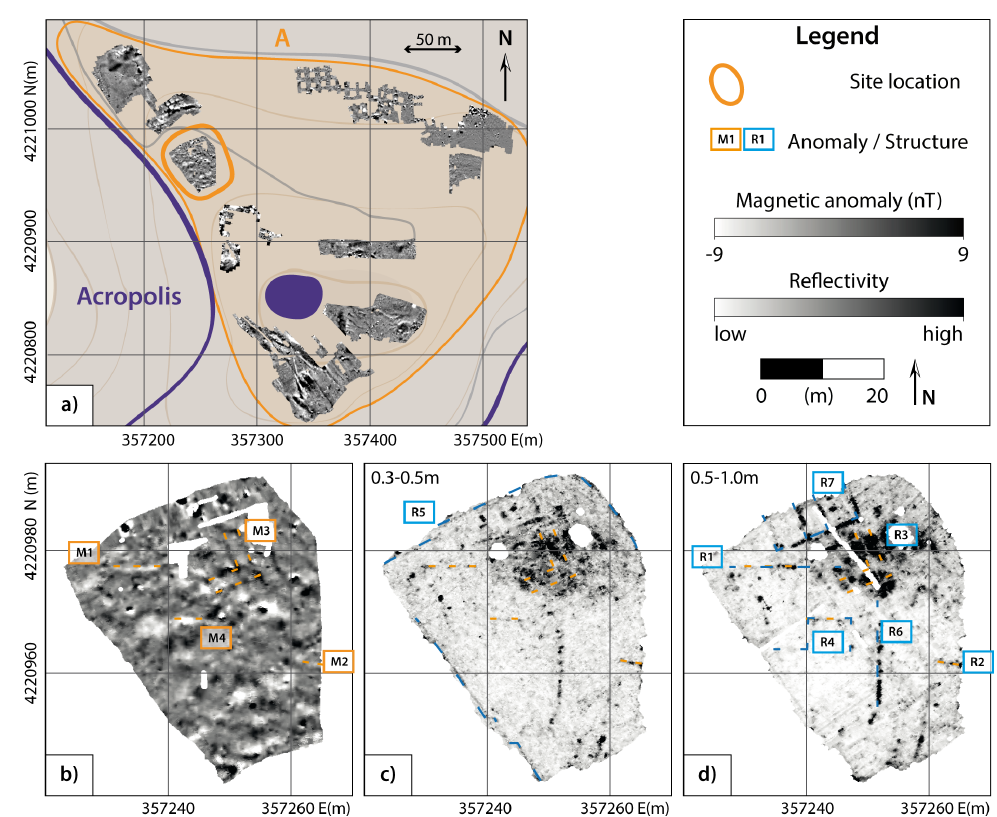
Figure 4. Case 1: Second lower terrace northwest of Aigeira’s acropolis. ( a ) Sketch of the first survey area in Aigeira (cf. area A in Figure 1b) with the magnetic map. The site location is marked (cf. Figure 3). ( b ) Magnetic map with marked anomalies (orange dotted lines). ( c ) Ground-penetrating (GPR) timeslice of 8–10 ns (approx. depth: 0.3–0.5 m) with marked structures (blue dotted lines). ( d ) GPR timeslice of 10–20 ns (approx. depth: 0.5–1.0 m) with marked structures (blue dotted